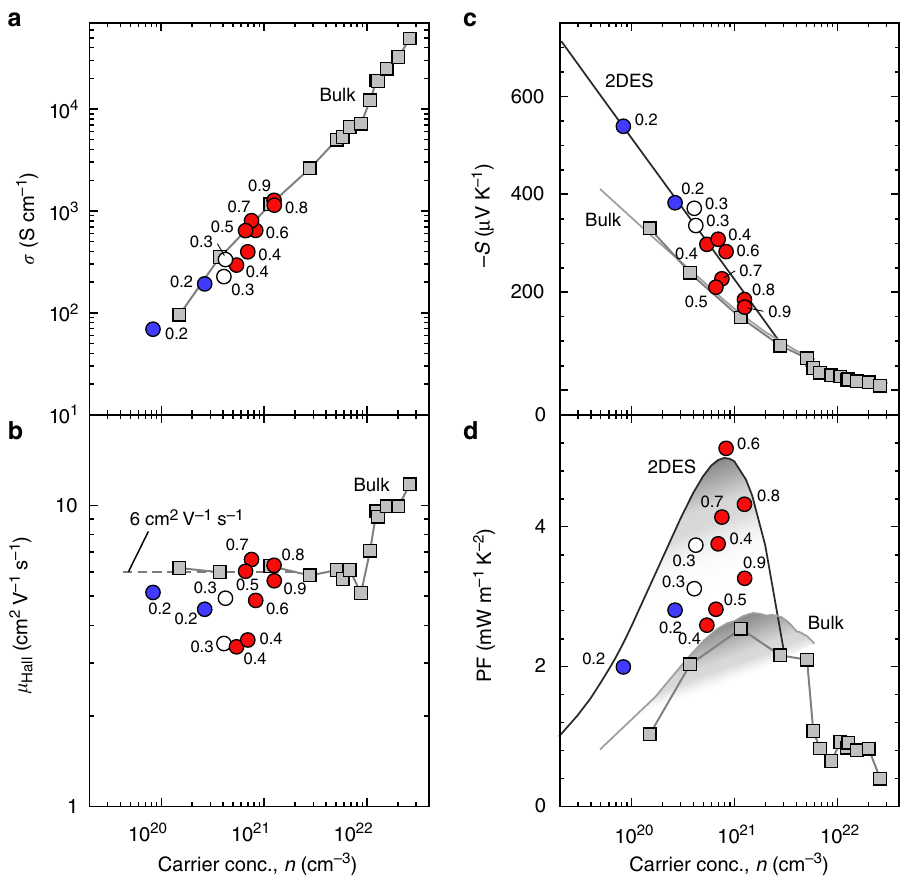
Fig. 5 Double enhancement of the thermoelectric power factor in a 2DES. Carrier concentration dependences of a electrical conductivity ( σ ), b Hall mobility ( μ Hall ), c thermopower ( − S ), and d power factor [PF ( S 2 · σ )] of [1 uc SrTi 1 − x Nb x O 3 | 11 uc SrTiO 3 ] 10 2DESs ( x is ranging from 0.2 to 0.9) at room temperature. Similar to the trends in the bulk values, σ increases almost linearly with n . μ Hall for lower x samples ( x ≤ 0.5) fl uctuates around 3 – 5 cm 2 V − 1 s − 1 , while that for higher x ones ( x ≥ 0.6) is ~6 cm 2 V − 1 s − 1 . Slope of – S versus log n for bulk SrTi – 198 μ V K − 1 , which is ∼ 1.5 times lower than 1 − x Nb x O 3 is – 300 μ V K − 1 for the 2DESs. Double enhancement of PF is seen in x = 0.6 (5.1 mWm − 1 K − 2 at n ∼ 8 × 10 20 cm − 3 ). Since the PF values are scattered due to the rather large distribution of μ Hall (3 – 6 cm 2 V − 1 s − 1 ), we calculated PFs using the relationship between S and n (c) at constant μ Hall (6 cm 2 V − 1 s − 1 ).